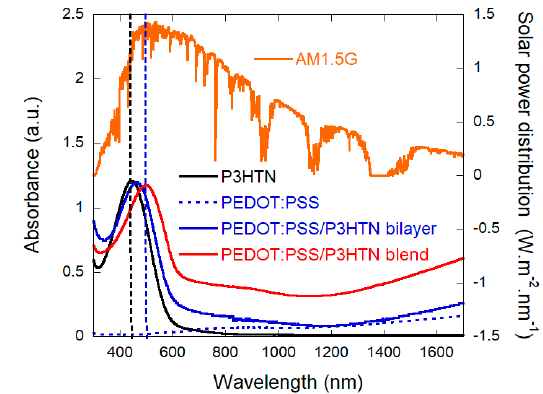
Figure 2. Absorption spectra of P3HTN films, PEDOT:PSS films, PEDOT:PSS / P3HTN bilayers, and